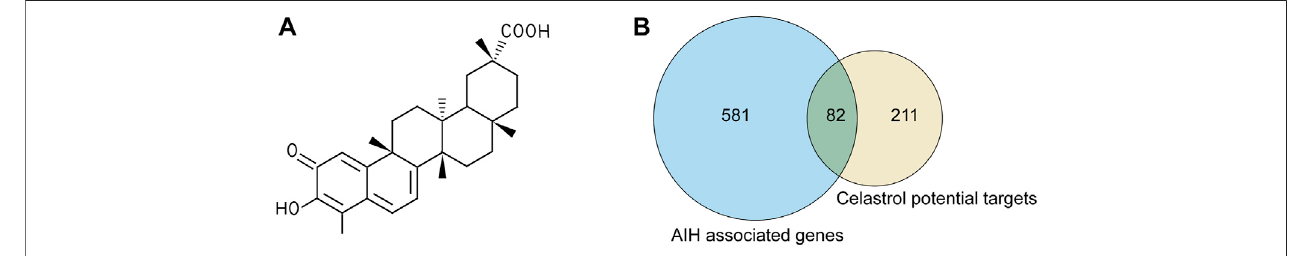
FIGURE 2 | The targets of celastrol were collected to explore the drug – disease relationships. (A) 2D structure of celastrol. (B) Venny diagram of celastrol and AIH intersection targets. Note: 82 celastrol-AIH intersection targets are shown in the middle.